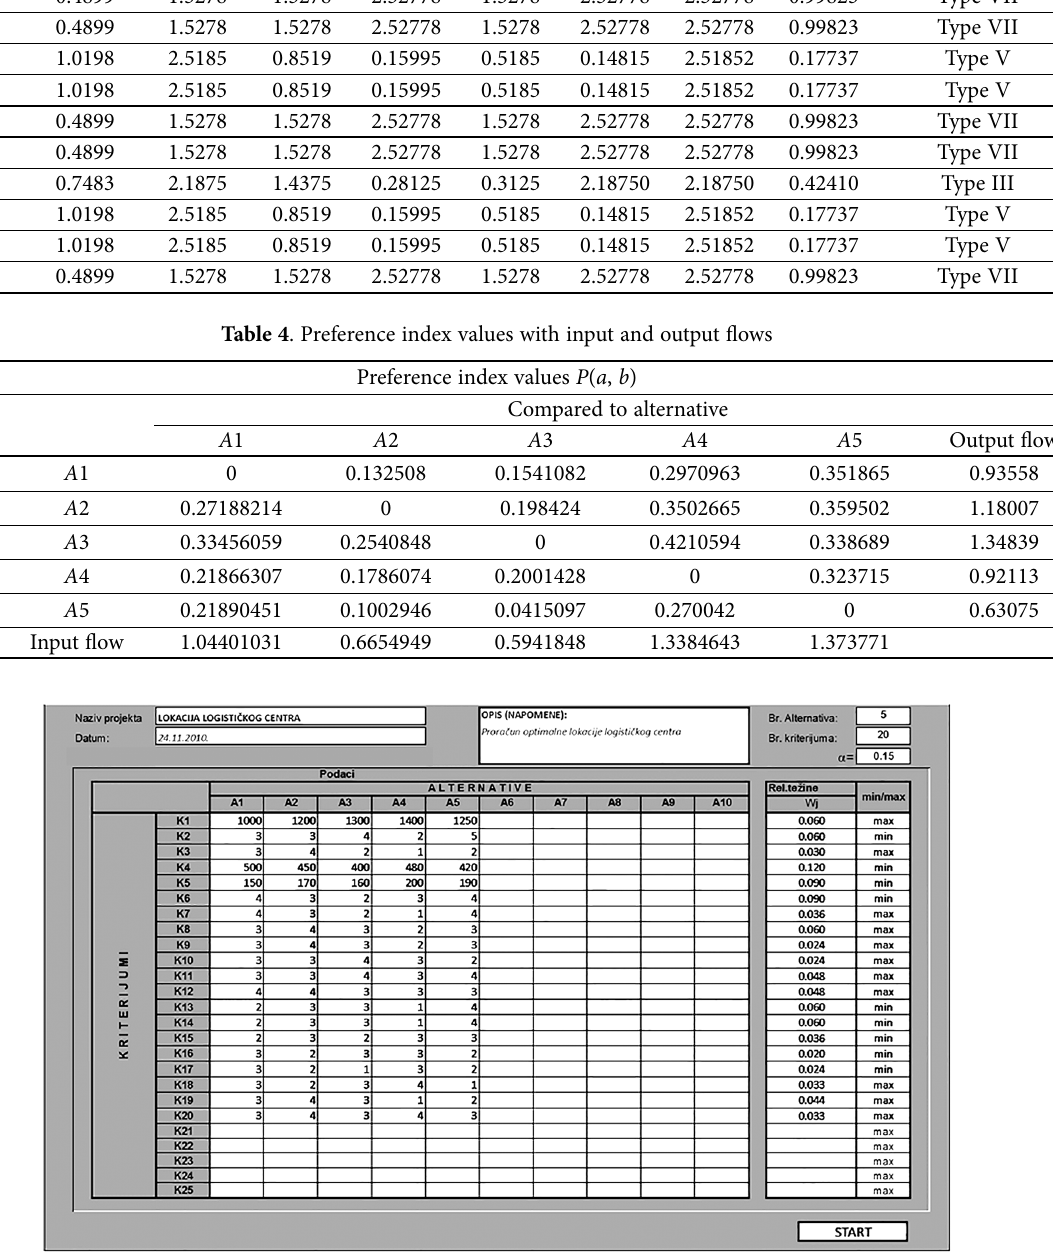
Fig. 4. Interface of the MODIPROM